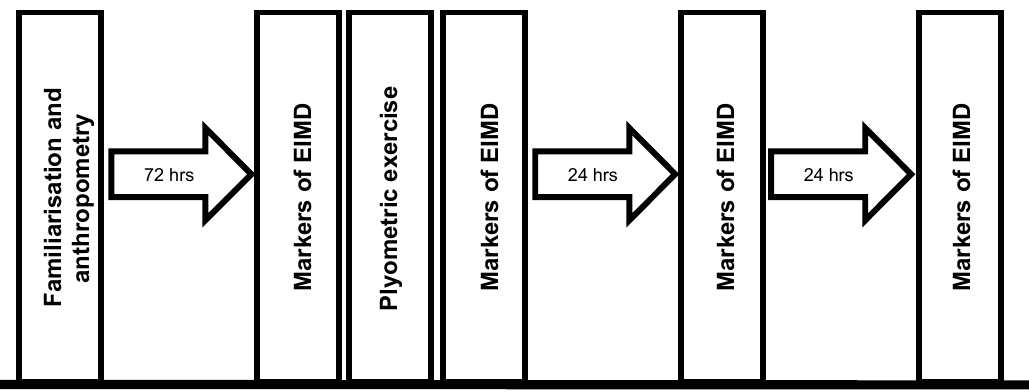
Figure 1. Schematic of study design.